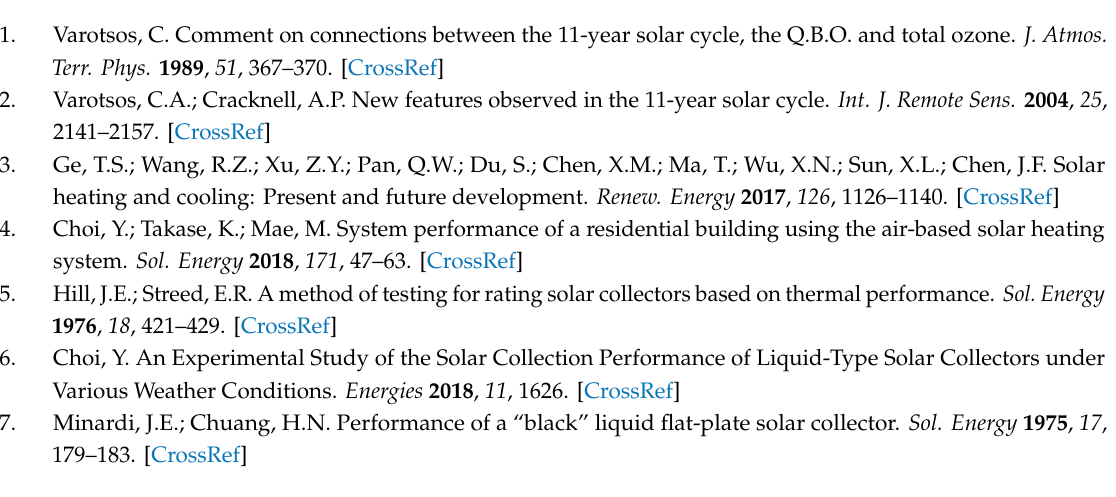
Table 6. Correlation between heating load of air-based solar heating system and climatic factors (five